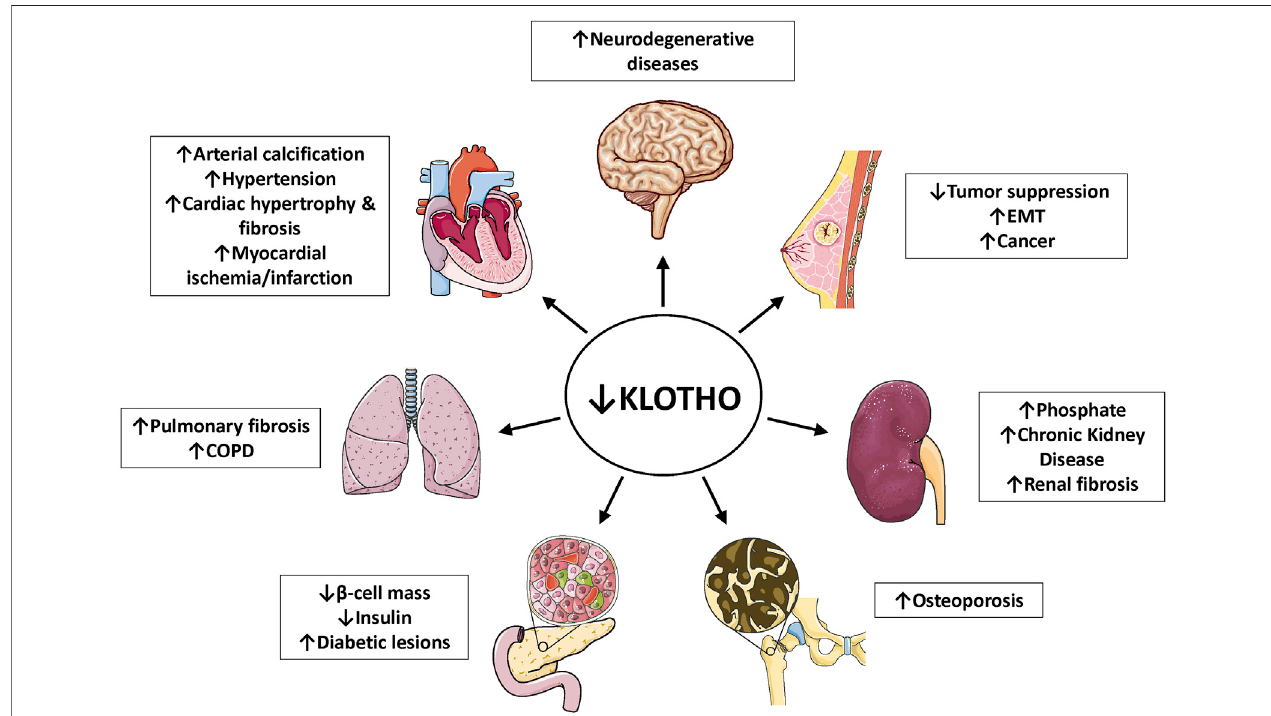
FIGURE4| Klothode fi ciencyassociateswithmultipleage-relateddiseases.Asoutlinedinthecaptions,depressedKlotholevelsarelinkedtohyperphosphatemia, chronic kidney diseases, multiple cardiovascular conditions, neurodegenerative diseases, several types of cancer, pulmonary fi brosis, COPD, bone disease and diabetes (reduced β -cell mass in the pancreas). References are listed in Table 1 . Abbreviations: COPD, chronic obstructive pulmonary disease; EMT, epithelial- mesenchymal transition.